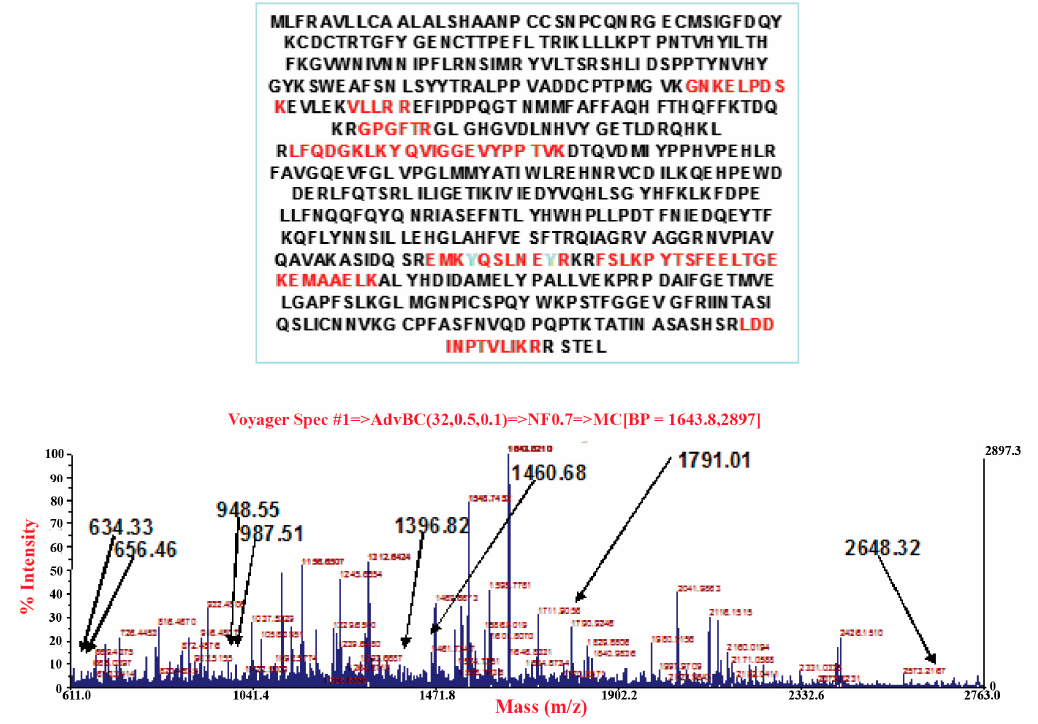
Figure 5. Identification by mass spectrometry of COX-2 after the intraplantar injection of carrageenan.